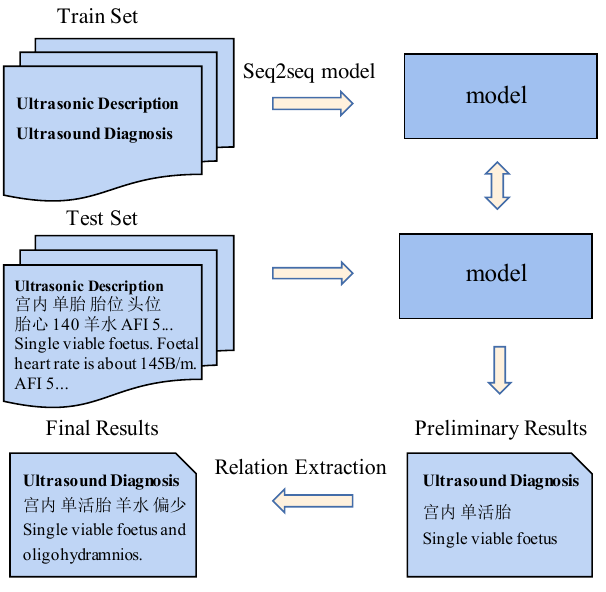
Figure 4. Pipeline of the information